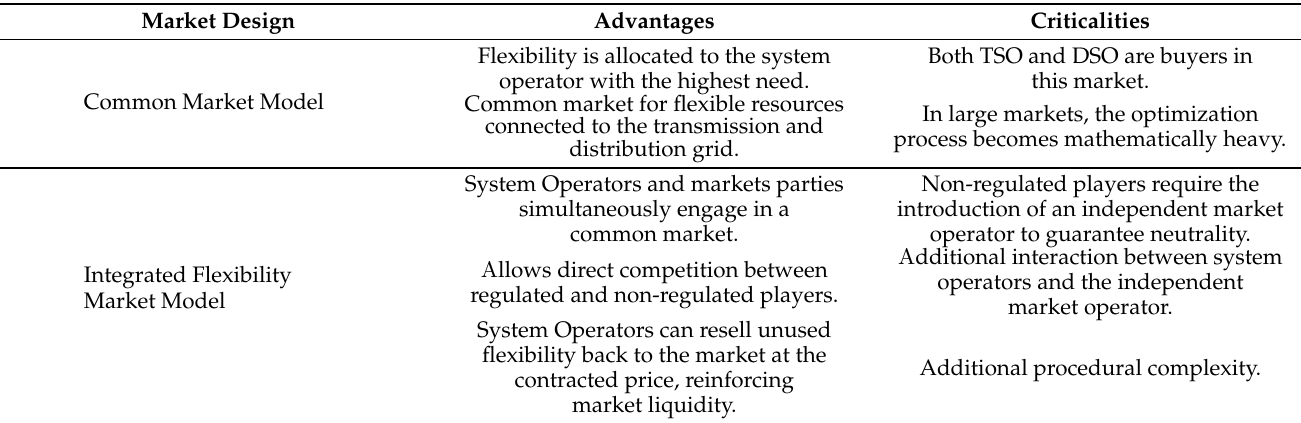
Table 2. Co-operational Market Designs for a Voltage Control Market as conceptualised in Gerard et al. Market